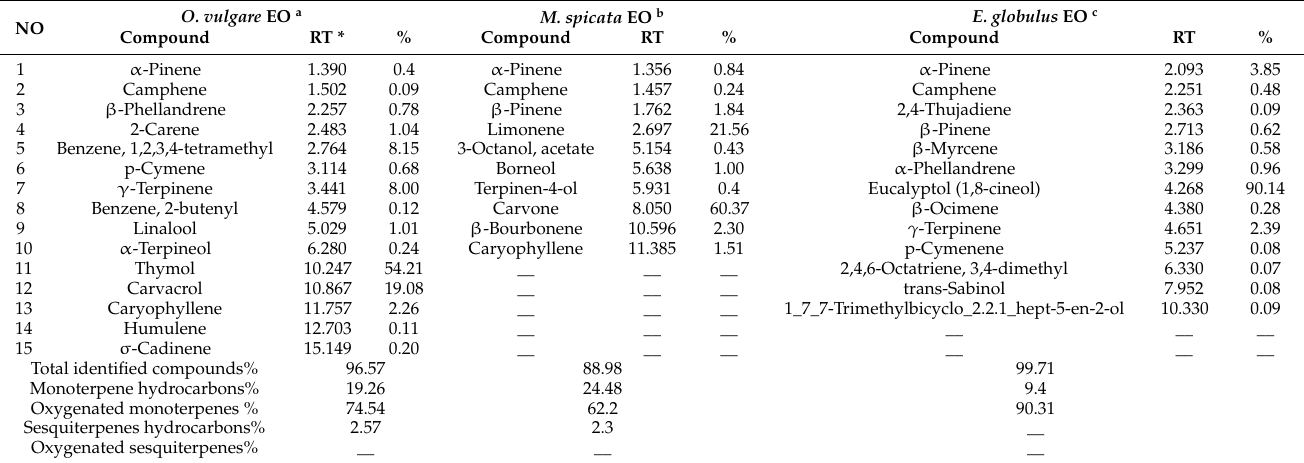
Table 2. Chemical composition of the studied